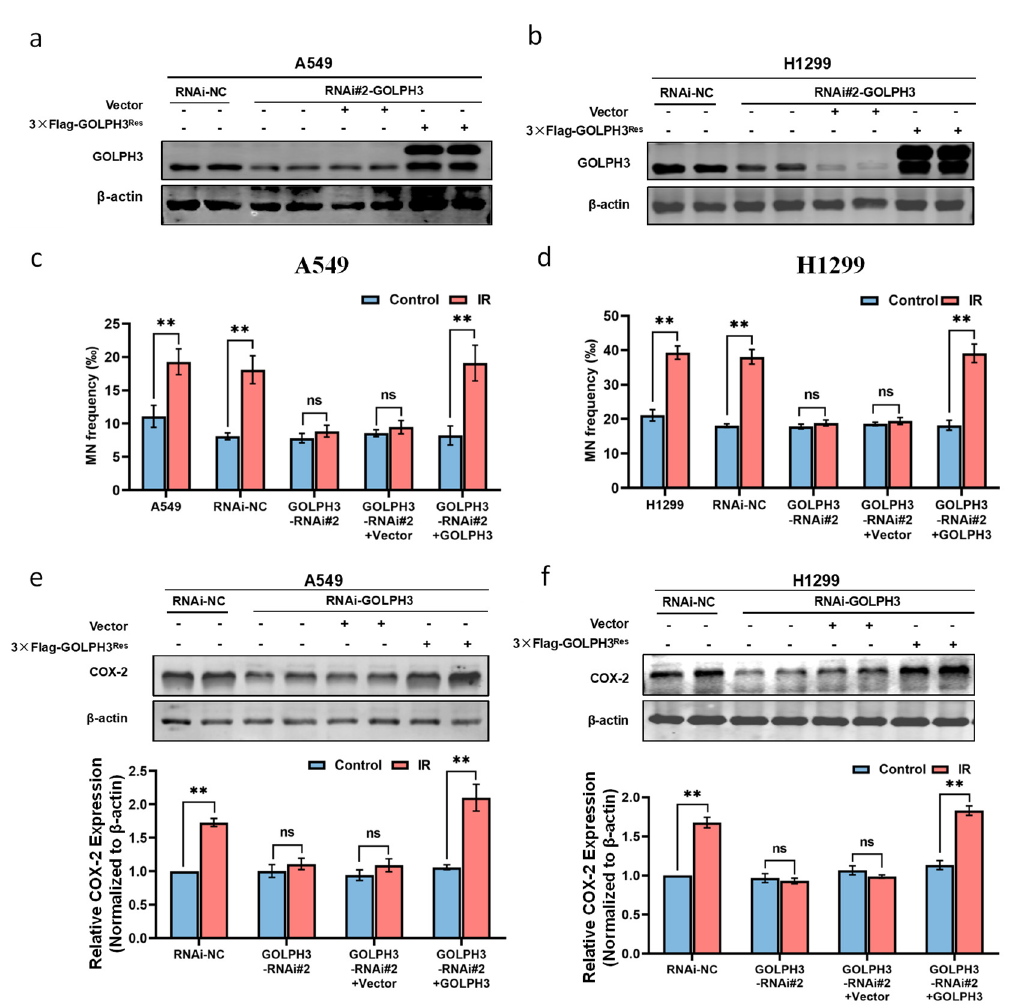
Figure 2. Re-expression of GOLPH3 in the irradiated GOLPH3 knockdown cells rescues RIBE. ( a,b ) Re-expression of GOLPH3 protein in GOLPH3 knockdown cell lines (A549/GOLPH3-RNAi#2 and H1299/GOLPH3-RNAi#2); ( c ) MN yields in the bystander A549 cells after co-culture with the irradiated A549/GOLPH3-RNAi#2 cells with GOLPH3 re-expression; ( d ) MN yields in bystander H1299 cells after co-culture with the irradiated H1299/GOLPH3-RNAi#2 cells with GOLPH3 re-expression; ( e ) representative Western blot and corresponding quantification of COX-2 protein in the bystander A549 cells after co-culture with the irradiated GOLPH3-RNAi#2 cells with GOLPH3 re-expression; ( f ) representative Western blot and corresponding quantification of COX-2 protein in the bystander H1299 cells after co-culture with the irradiated GOLPH3-RNAi#2 cells with GOLPH3 re-expression. **: p < 0.01; ns: not significant.